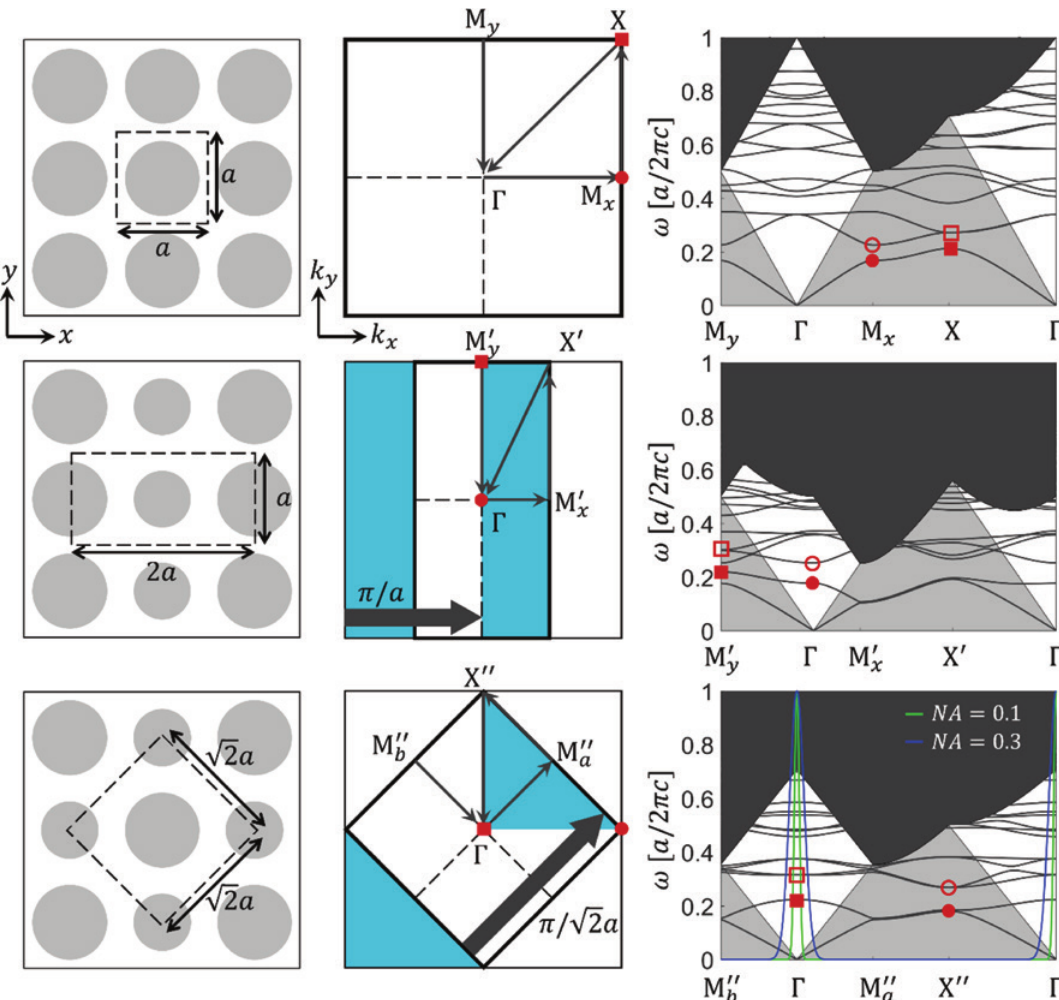
Figure 3: 2D DHCGs. Three examples of 2D gratings are shown in real space (column 1, black dashed box representing the unit cell of the structure) and k -space (column 2, showing the first Brillouin zone (FBZ) and arrows tracing the path through k -space for band diagram calculations), and their band diagrams are calculated for an infinitely tall grating with the electric field pointed out of plane (column 3, light gray areas representing bound modes, dark gray areas representing modes with high diffractive orders, and closed/open markers denoting bonding/anti-bonding modes). The top row shows an unperturbed grating, with a few modes of interest marked for comparison with the two DHCGs in the second and third rows. The second row shows a dimerizing perturbation doubling the period in the x -direction; the FBZ has halved in the k direc- x tion. The blue portion of the unperturbed FBZ is translated into the new, perturbed FBZ by reciprocal lattice vector of the perturbed grating (indicated by the large dark arrow). Modes at the original M point (marked by red circles) have now moved to the new Γ point, making them x ′ point, still under the accessible to free-space excitation. The modes at the original X point (marked by red squares) moved to the new M y point light line. The third row shows a dimerizing perturbation changing the period by 2 and rotating the unit cell by 45 ° . The original M x has now moved to the X ″ point, and the original X point has moved to the Γ point. As the band near the original X point is very flat, the resulting modes at the new Γ point have very flat bands (particularly that marked with an open red square). Overlaid in the final panel is the spread of power in k- space of a Gaussian beam with frequency of the closed red square, with two different values of numerical aperture, NA = λ / π w , where w is the e −2 waist radius of the Gaussian 0 0